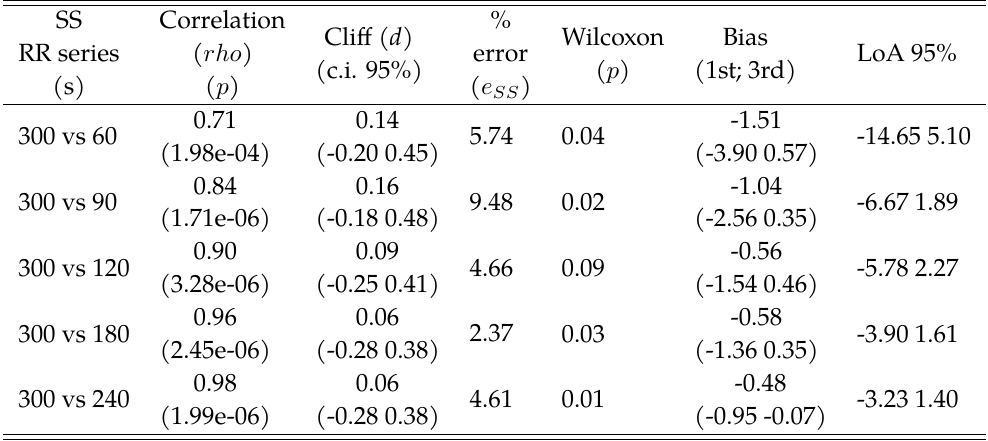
Table 4: Analysis of concordance between GS and different time series of the SS index.